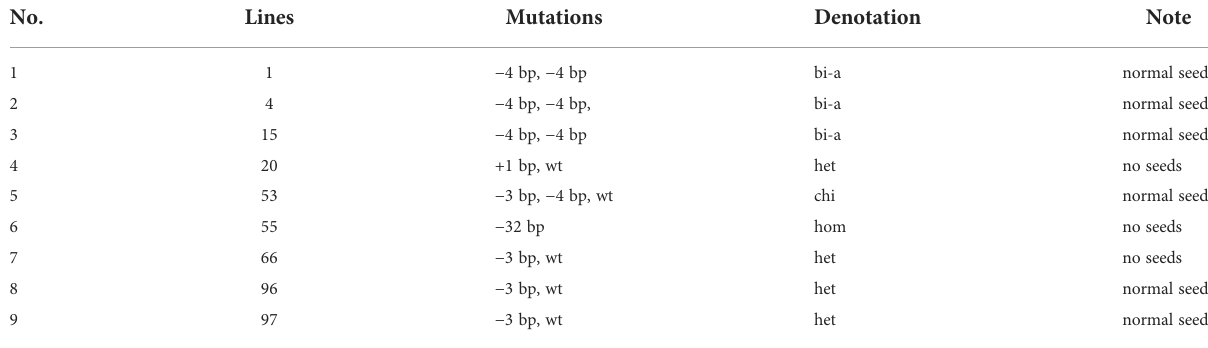
TABLE 1 The mutations detected in 97 regenerated T 0 plants by Sanger sequencing of plasmids derived from PCR products.